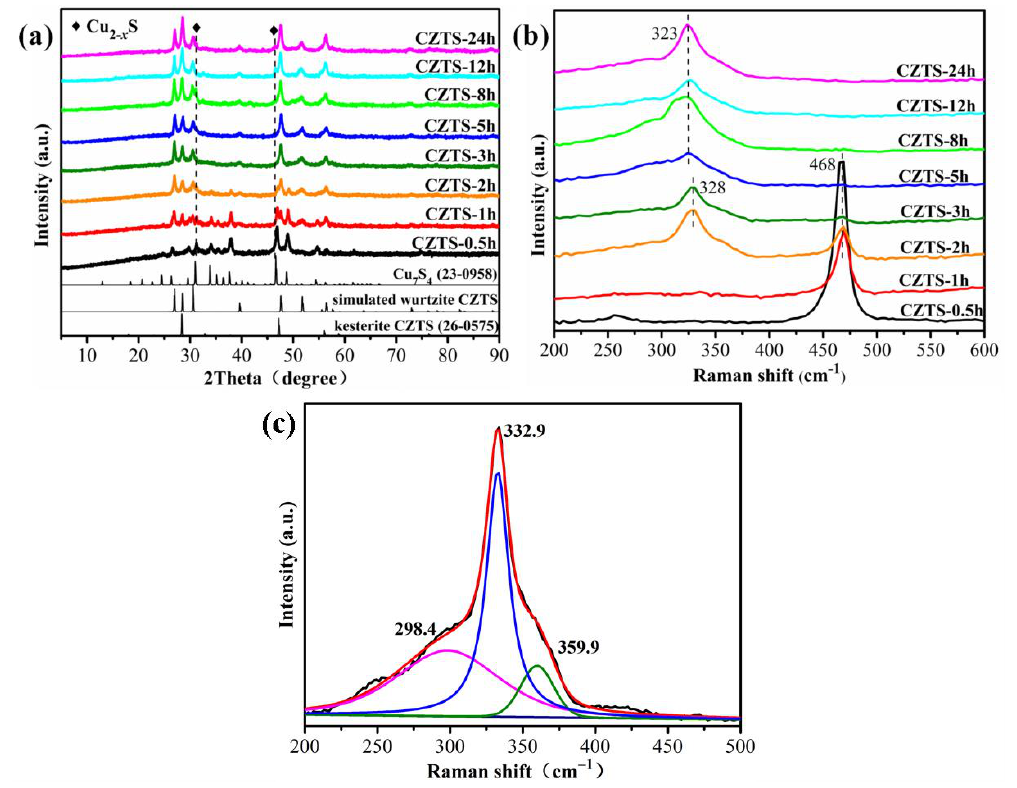
Figure 1. The time-dependent ( a ) XRD patterns and ( b ) Raman spectra of CZTS samples, and ( c ) the SERS of CZTS-24 h sample (black line: real curve; red line: fitted curve; green, blue and magenta: the three splitting peaks of fitted curve).